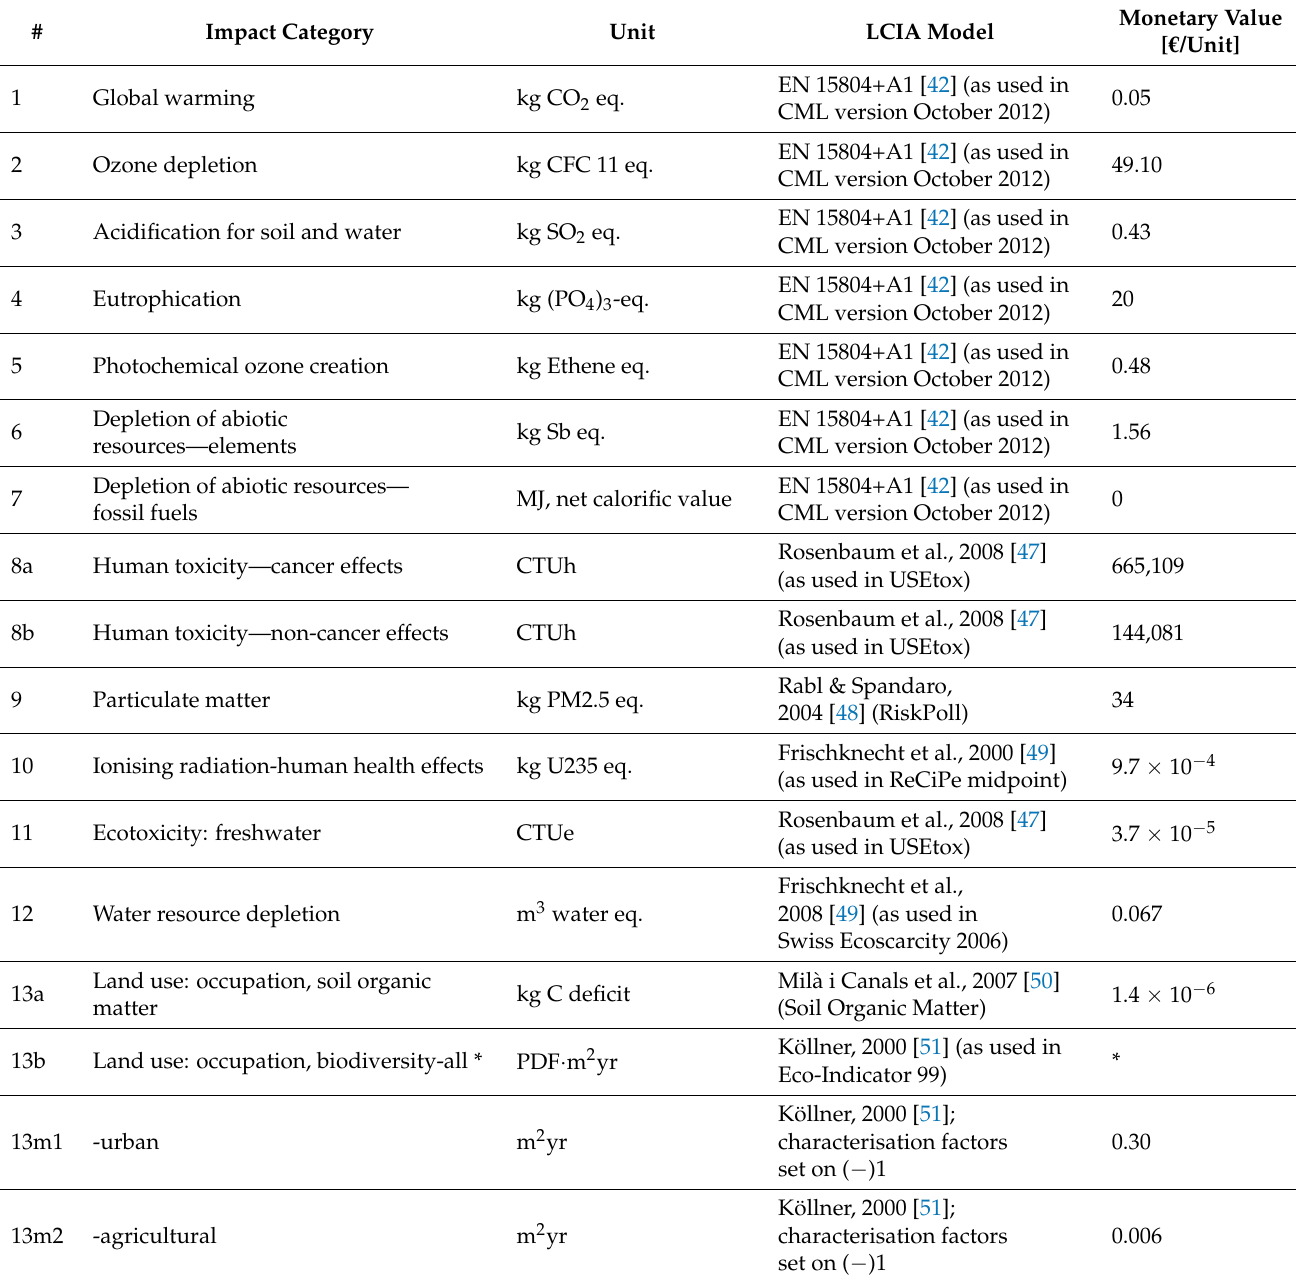
Table 1. Overview of the applied environmental impact categories and the corresponding units, LCIA models and monetization factor